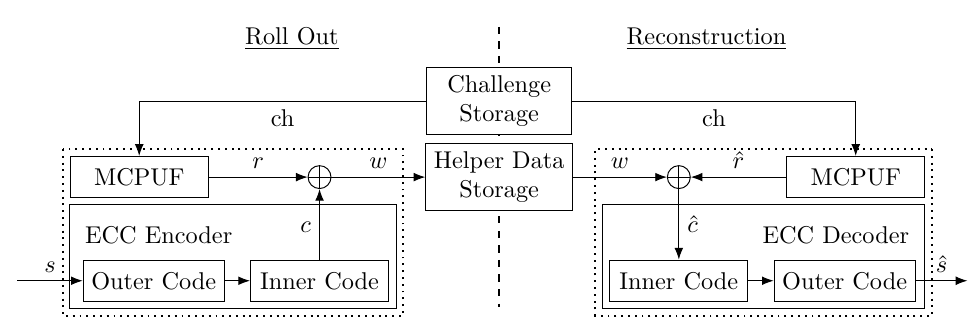
Figure 1: Visualization of the key-storage scenarios with PUF s: At some point in time – during Roll Out – a key is stipulated for the device. Later – during Reconstruction – the key is derived from the noisy PUF given public helper data and